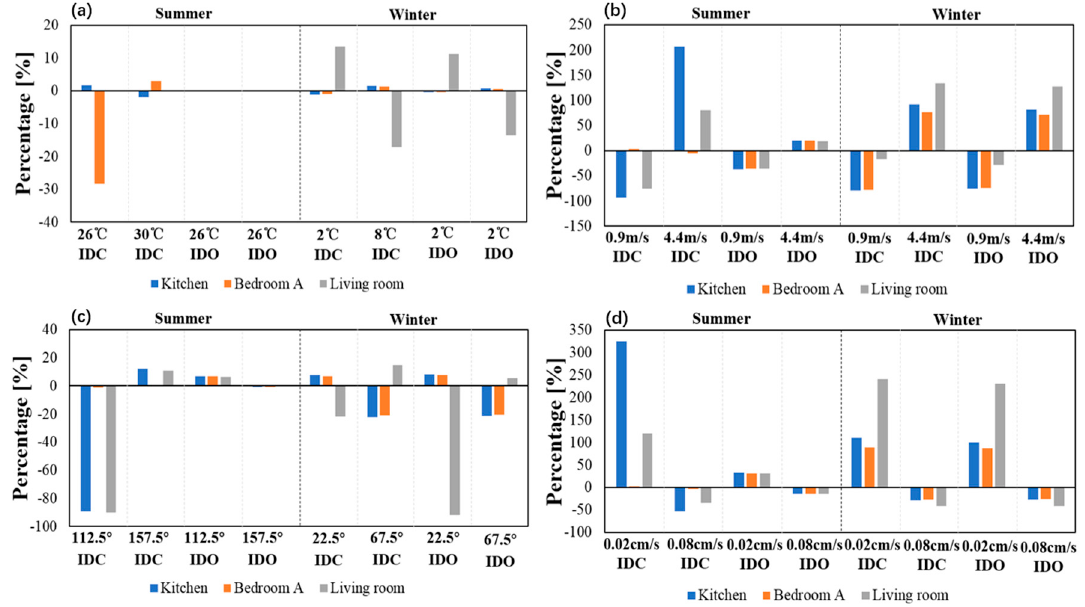
Figure 4. Influencing factors of indoor ozone concentration. ( a ) Temperature, ( b ) wind speed, ( c ) wind direction, ( d ) ozone deposition velocity.